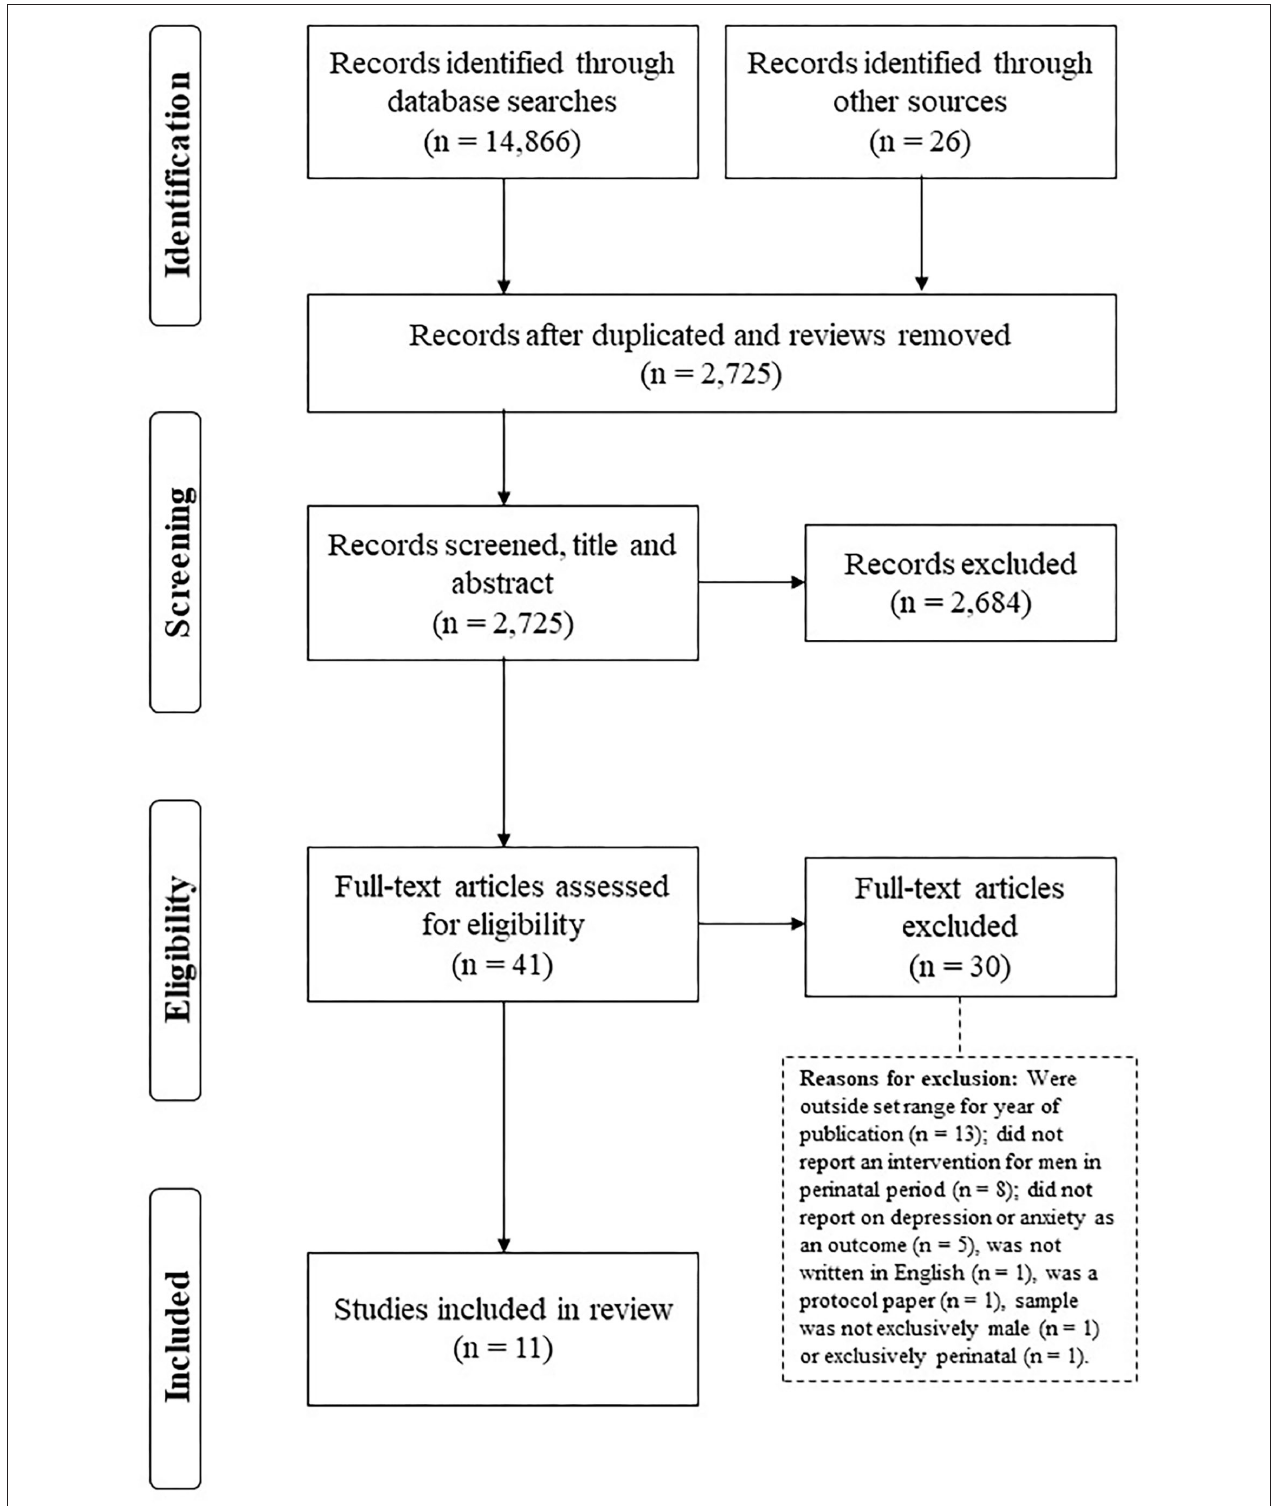
FIGURE 1 | Study selection flow